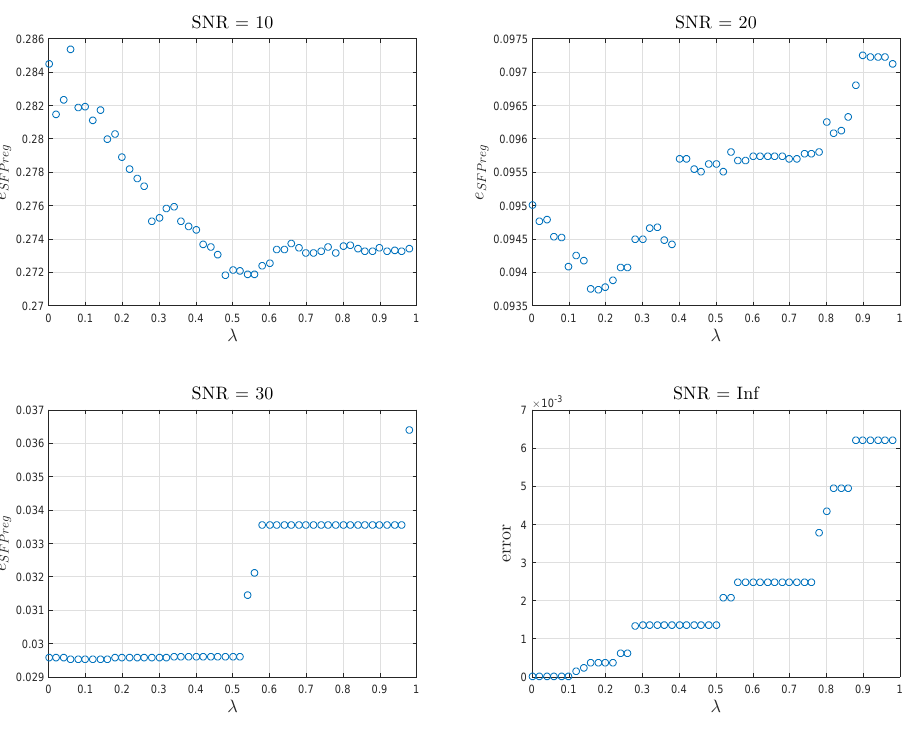
Figure 1. Mean representation error depending on λ for K = 11, for matrix conditioning of